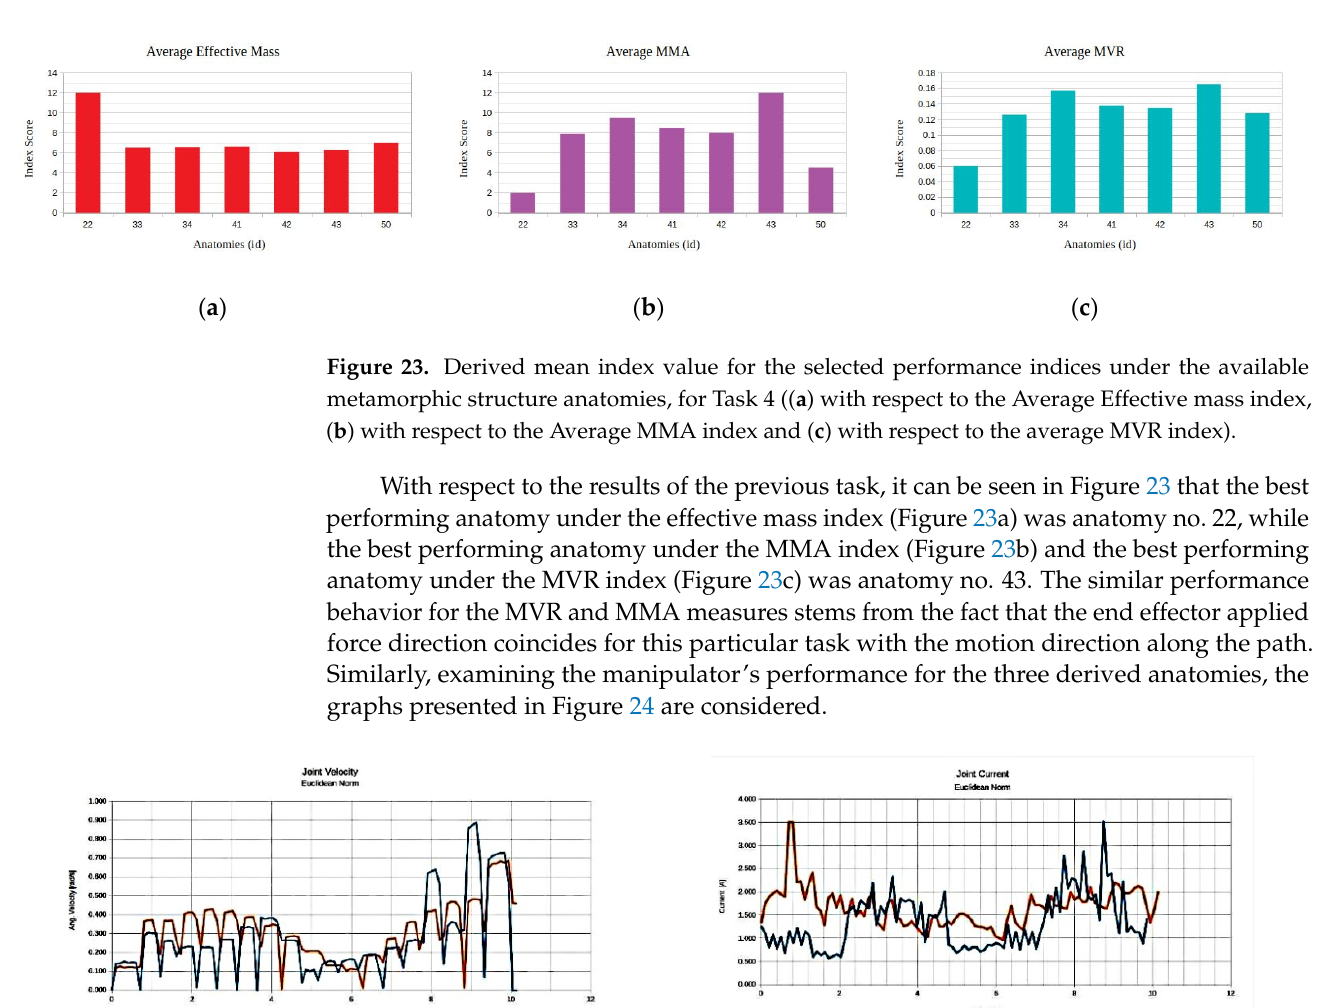
Figure 22. Optimal anatomy of the metamorphic manipulator derived under the MMA measure for Task 3.